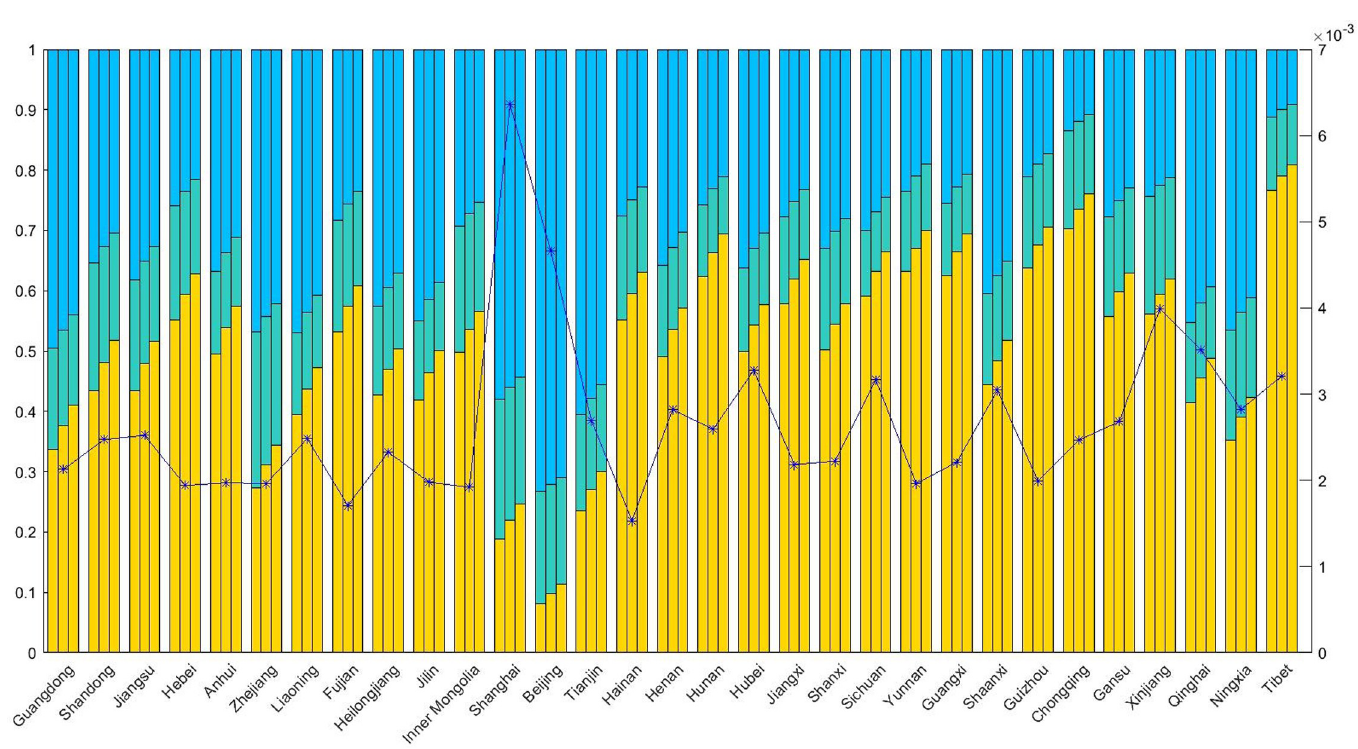
Fig 5. The contribution rate of medical resources at different levels toward accessibility in three